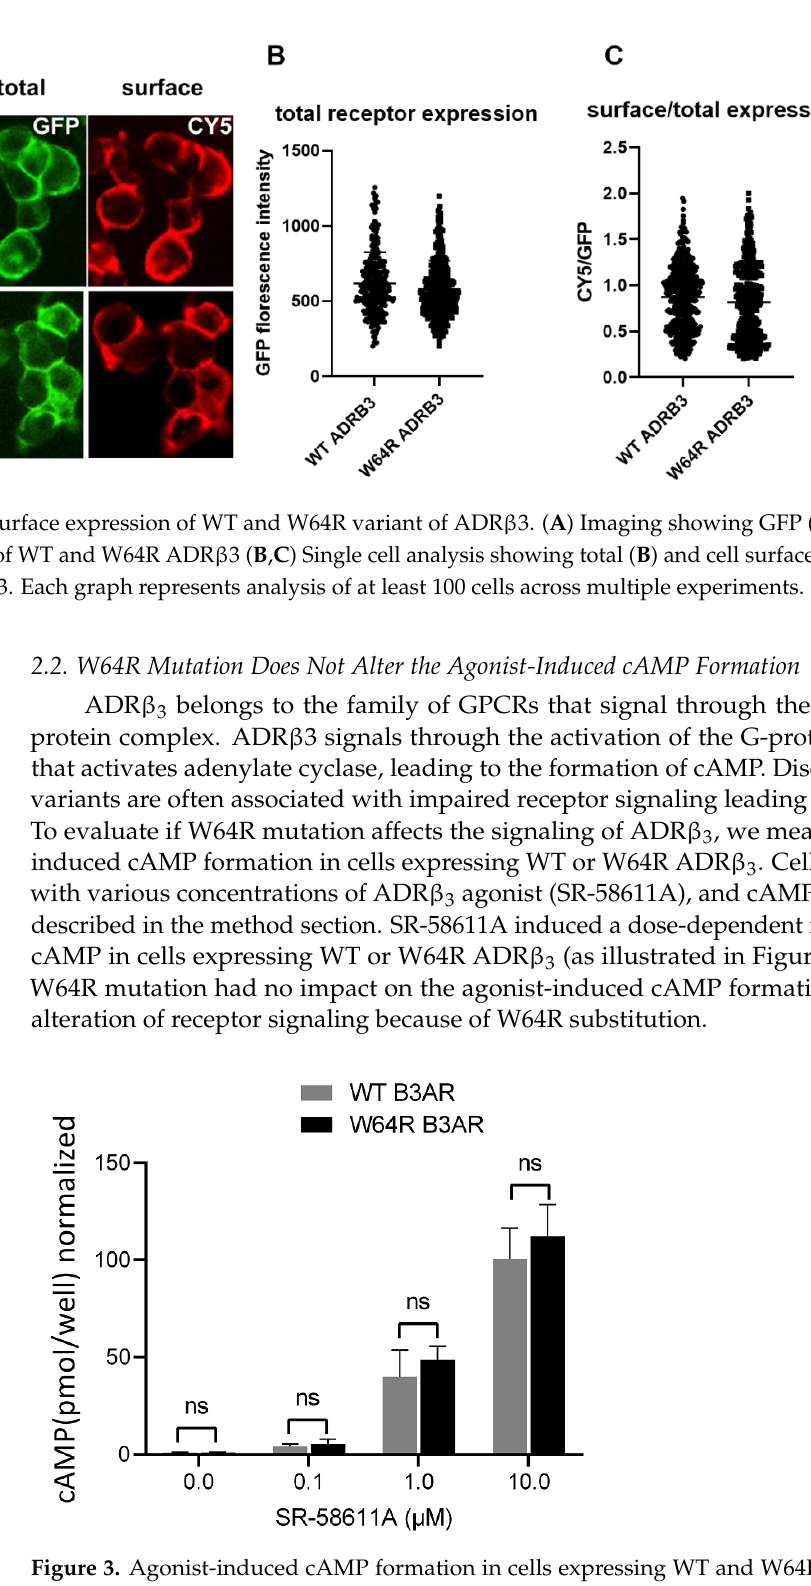
Figure 1. Engineering of HA-ADR β 3-GFP reporter construct and its functional validation. ( A ) HA-ADR β 3-GFP reporter construct was generated by PCR cloning as described in the method section. ( B ) HEK293 cells stably expressing HA-ADR β 3-GFP and visualized under fluorescence microscope (GFP channel). ( C ) β 3 agonist-induced cAMP formation in cells expressing empty vector, untagged ADR β 3, or HA-ADR β 3-GFP.